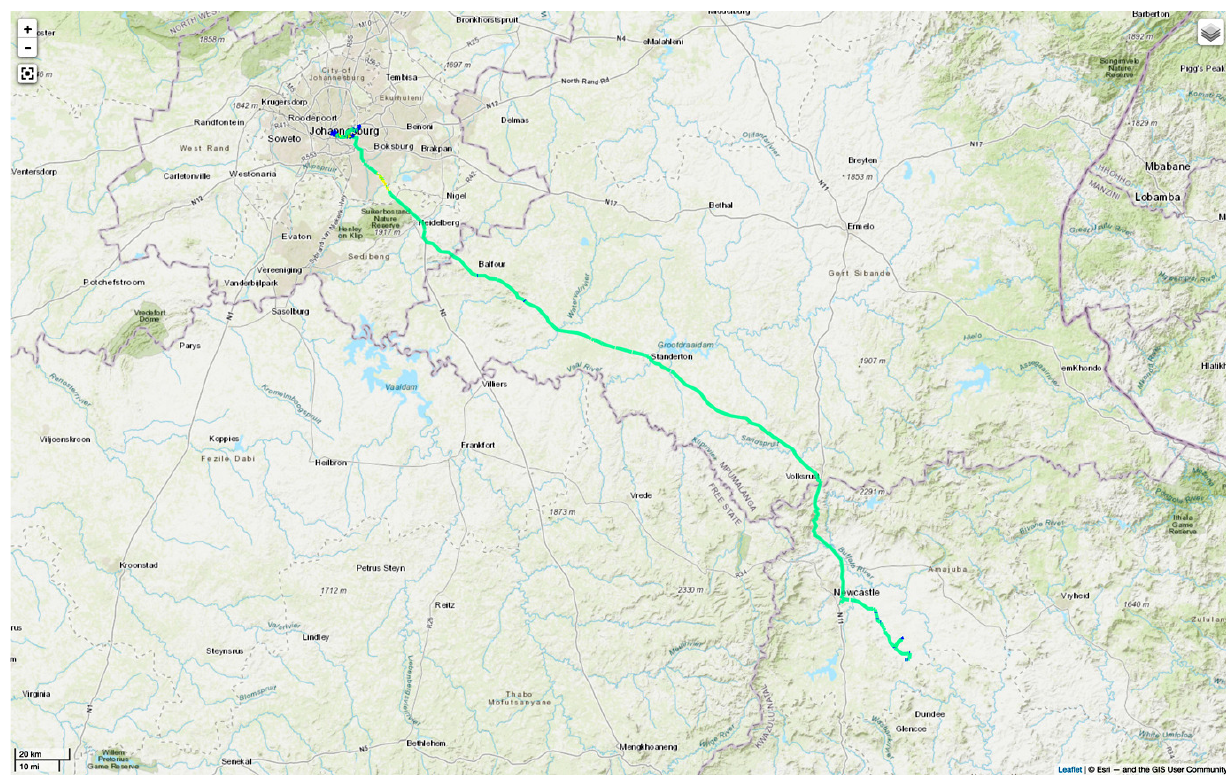
Figure 3. Map produced by the location data of participant D01. The green line indicates how she travelled with a minibus taxi “home” to KwaZulu Natal. Source: Map by Chantal Bekkering,